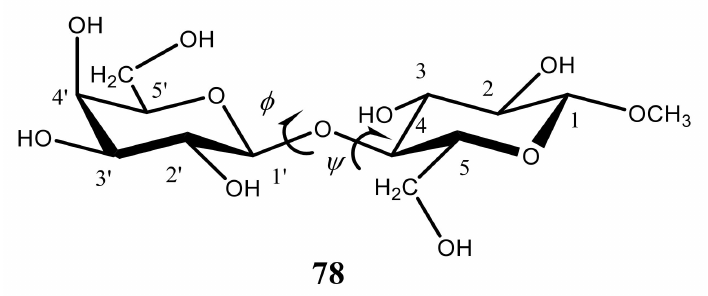
Figure 40. Chemical structure of methyl β -D-galactopyranosyl-(1 → 4)- β